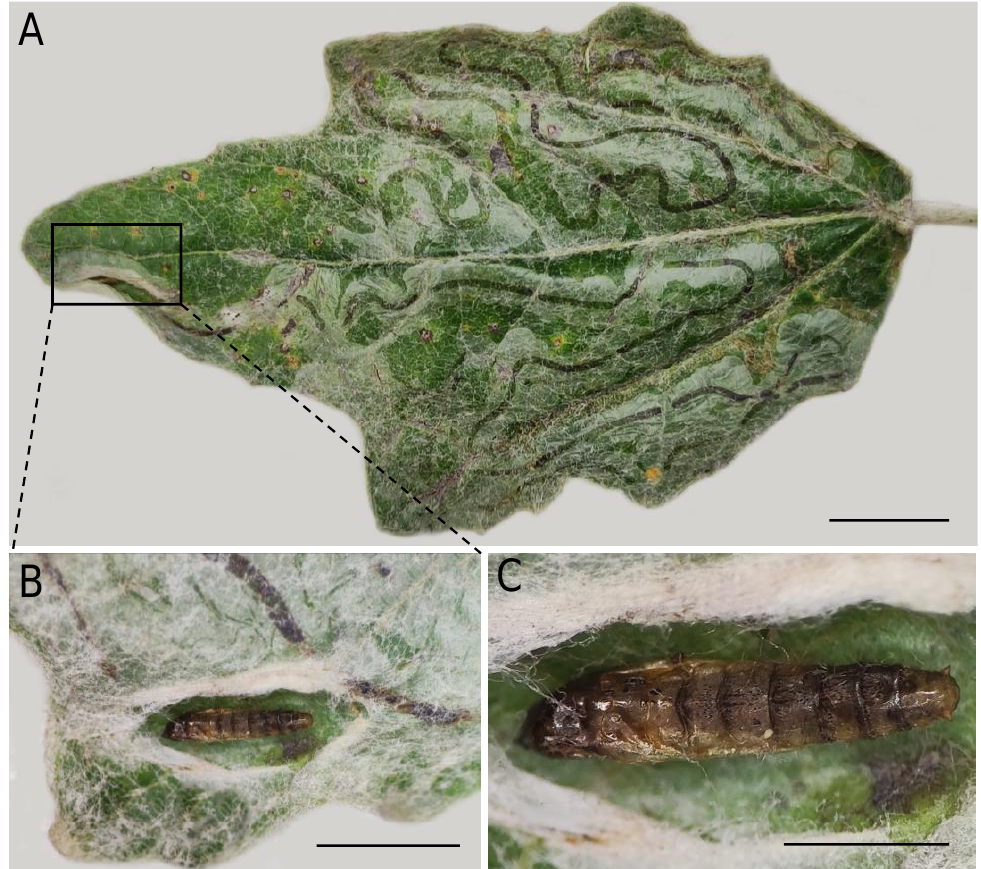
Figure 8. The mines of Phyllocnistis labyrinthella on Populus alba found in the Volčji Potok Arboretum, Slovenia, 9 August 2022. ( A – C ) a mine with a live pupa in it. Scale: ( A ) 10 mm, ( B ) 5 mm, ( C ) 2 mm. Photo: N.I. Kirichenko, S. Gomboc.